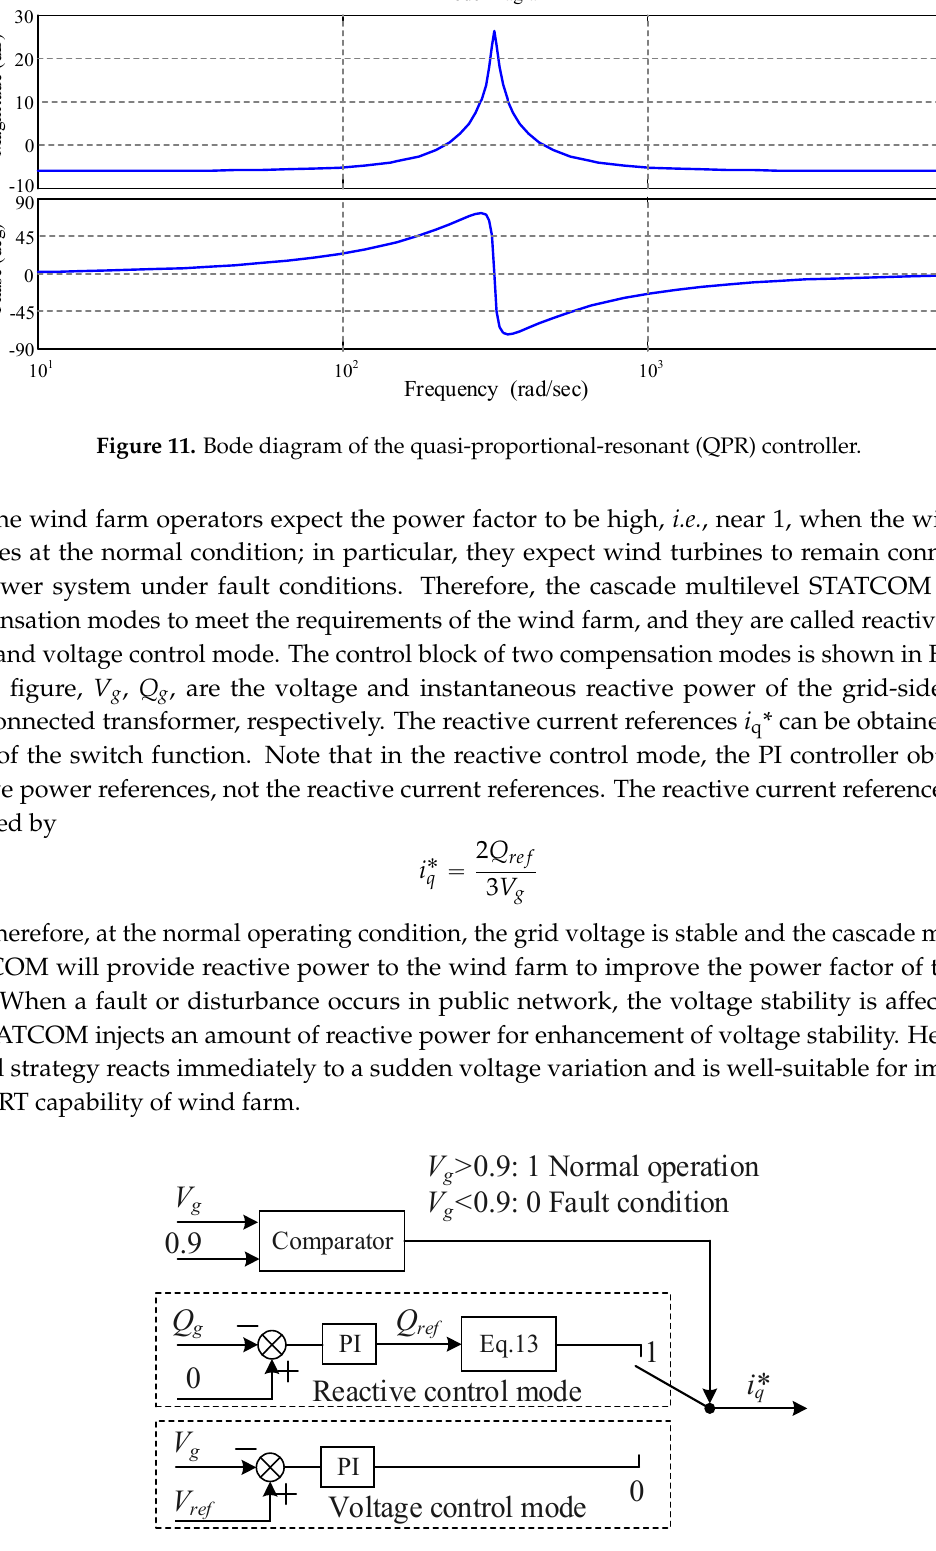
Figure 12. Control block of two compensation mode.